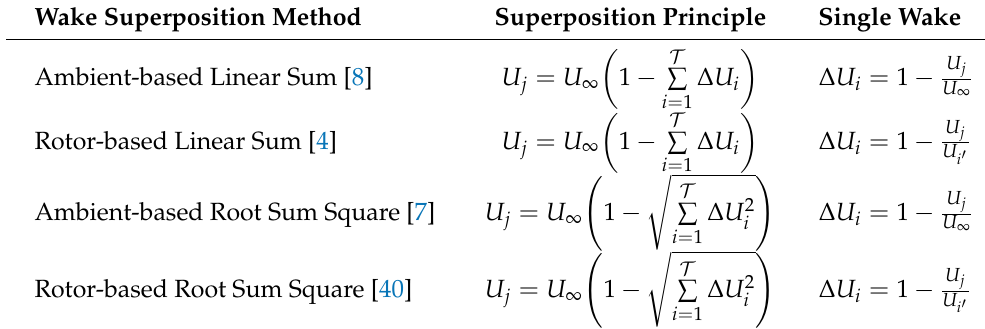
Table 1. Wake Superposition methods for computing the mean wind velocity due to multiple